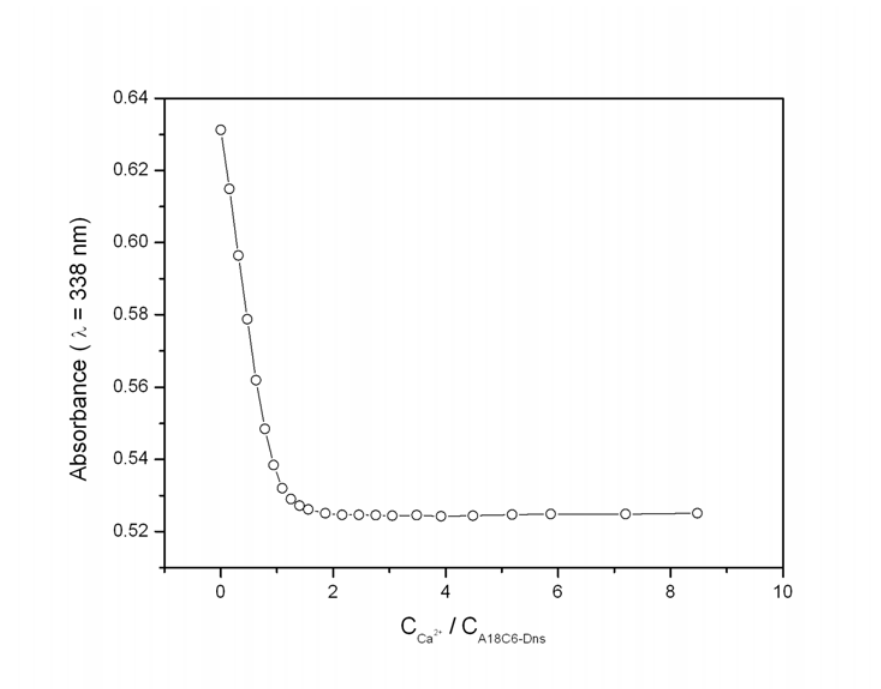
Fig. 3a Dependence of absorbance at 338 nm for A18C6-Dns as a function of molar ratio C Ca 2+ /C A 18 C 6 − Dns .